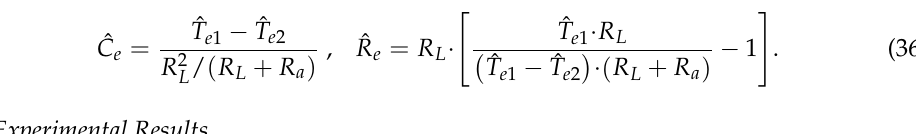
Figure 13. Simplified representation of the diagram in Figure 12.